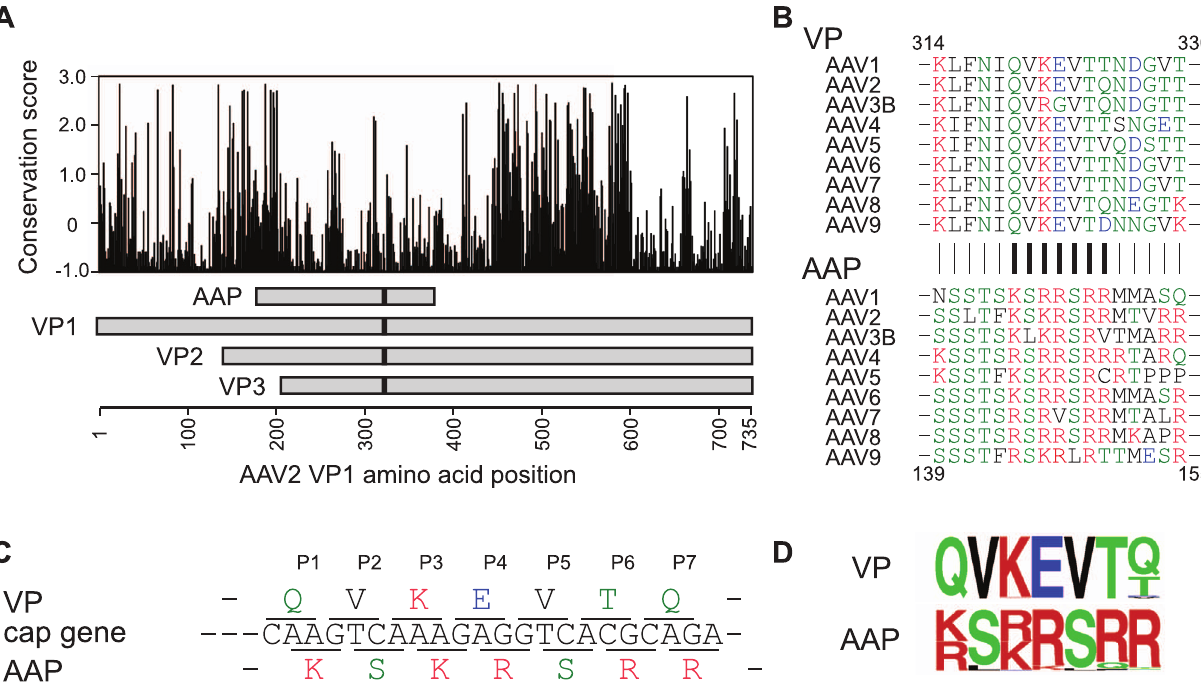
Figure 1. The VP/AAP overlapping ORFs in the AAV2 cap gene. ( A ) Organization of the cap gene and evolutionary conservation of the VP proteins. Evolutionary conservation scores were calculated by a ConSurf analysis [39] of 128 AAV species. ( B ) Sequence alignment of amino acids around the VP and AAP overlapping regions indicated with black lines in Panel A. The QVKEVTQ/KSKRSRR motifs are indicated with seven thick vertical lines. The numbers indicate amino acid positions. ( C ) VP/AAP-overlapping ORFs encoding the QVKEVTQ/KSKRSRR motifs. ( D ) Amino acid sequence logos (frequency plots) representing the VPs and AAPs derived from 128 AAV species.